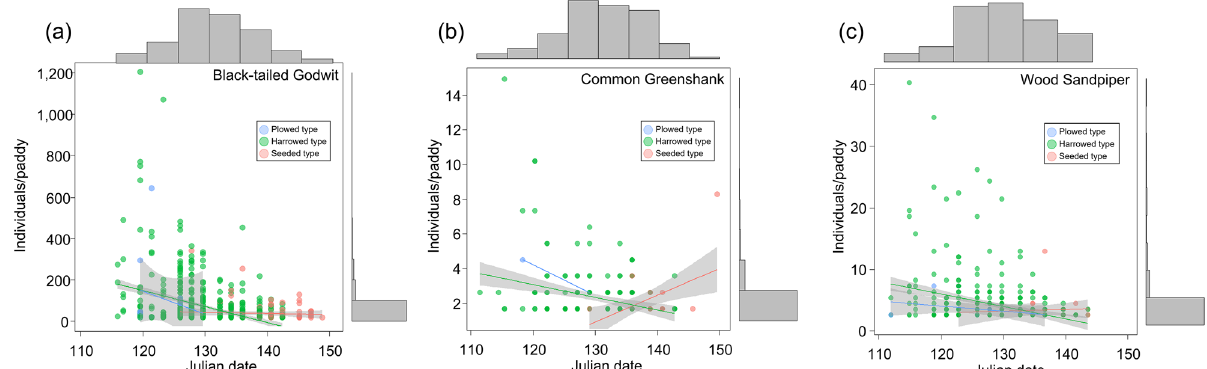
Figure 1. Scatterplot of Julian date and bird density (individuals/paddy) of shorebird species. Each variable represents marginal histograms and 95% confidence interval. The Julian date was divided according to field type (plowed, harrowed, and seeded field): ( a ) Black-tailed Godwit; ( b ) Common Greenshank; ( c ) Wood